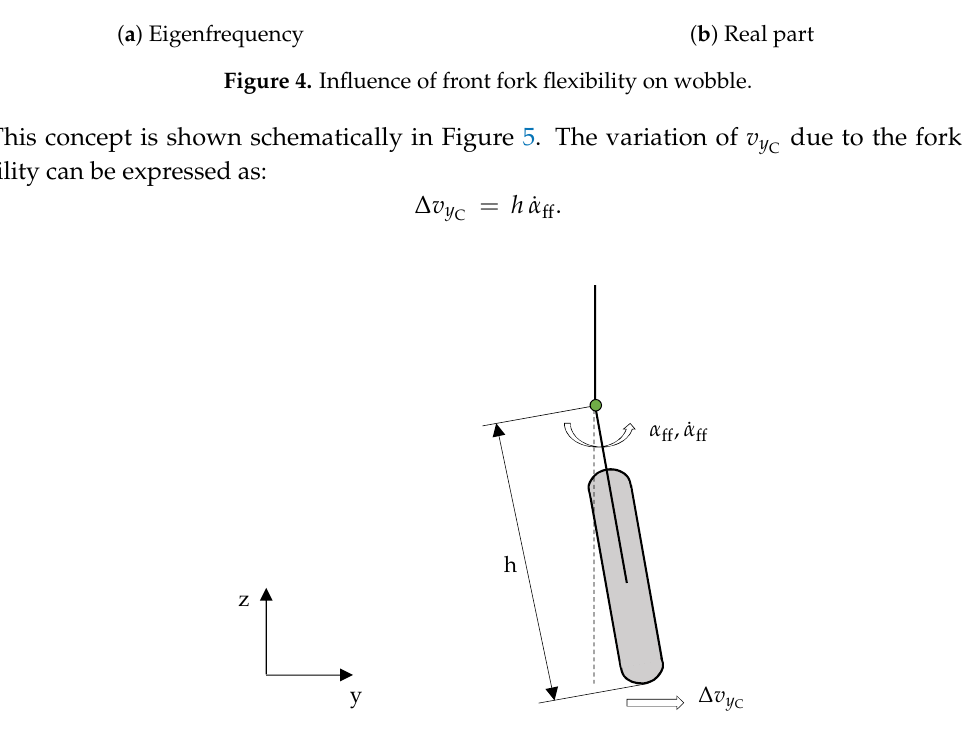
Figure 5. Variation of the lateral velocity at the contact point due to lateral fork